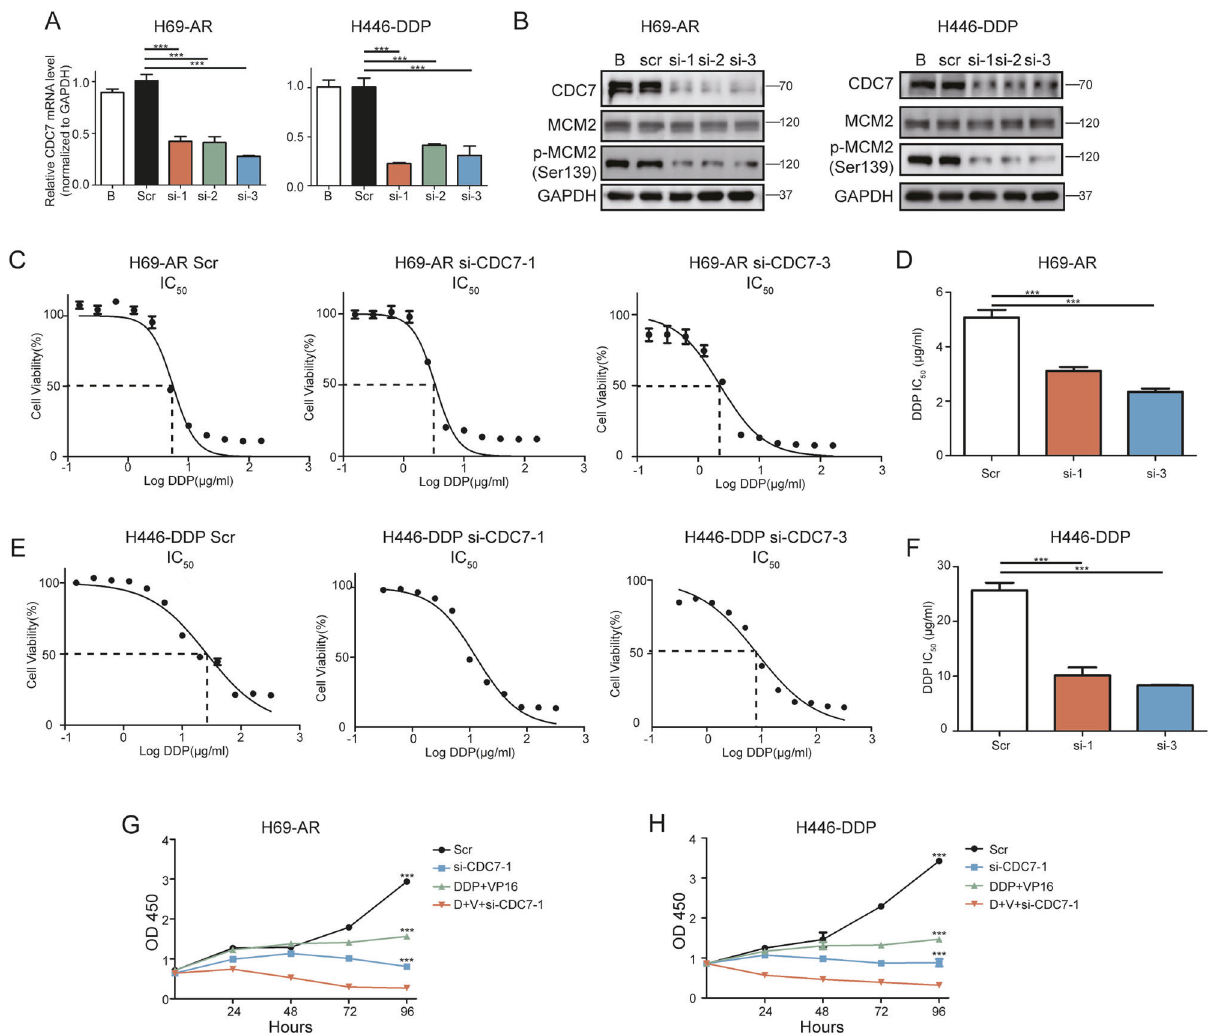
Fig. 2 CDC7 silencing improves chemo-treatment ef fi ciency in resistant SCLC cells. A qRT-PCR analyses of CDC7 expression in H69-AR(left) and H446-DDP(right) 48 h after transfected with CDC7 siRNA. B Western blot analyses of CDC7 and MCM2 in H69-AR(left) and H446-DDP(right) 48 h after transfected with CDC7 siRNA. IC 50 and the statistics of IC 50 of DDP in H69-AR ( C , D ) and H446-DDP ( E , F ) transfected with scramble or si- CDC7 . Cell viability of H69-AR ( G ) and H446-DDP ( H ) transfected with si- CDC7 using CCK-8 assay. All data are representative of three independent experiments (mean ±